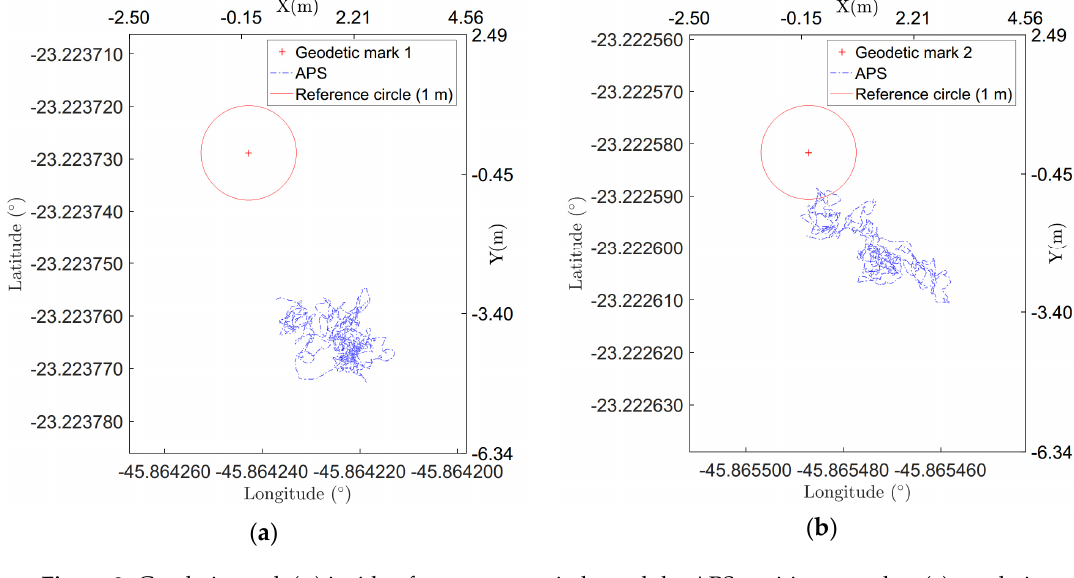
Figure 3. Geodetic mark ( + ) inside of a one-meter circle, and the APS position samples: ( a ) geodetic mark 1, ( b ) geodetic mark 2. Table 1. Mean error, ϵ mean , and standard deviation, σ m , in comparison with two geodetic marks. Geodetic.